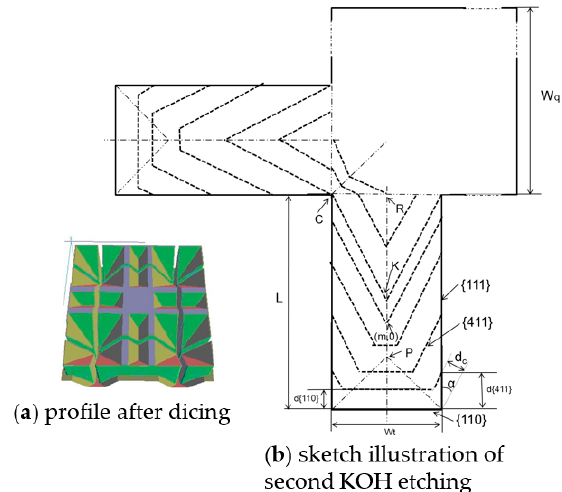
Figure 3. Sketch illustration of successive lateral etching beneath compensation strip. (After dicing, second KOH etching).